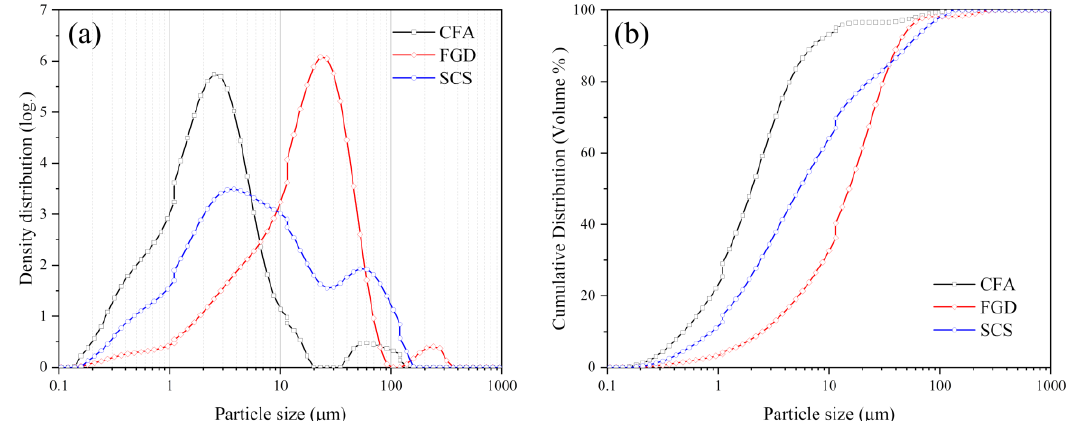
Figure 4. ( a ) The cumulative grain size distribution and ( b ) differential grain size distribution of raw materials.